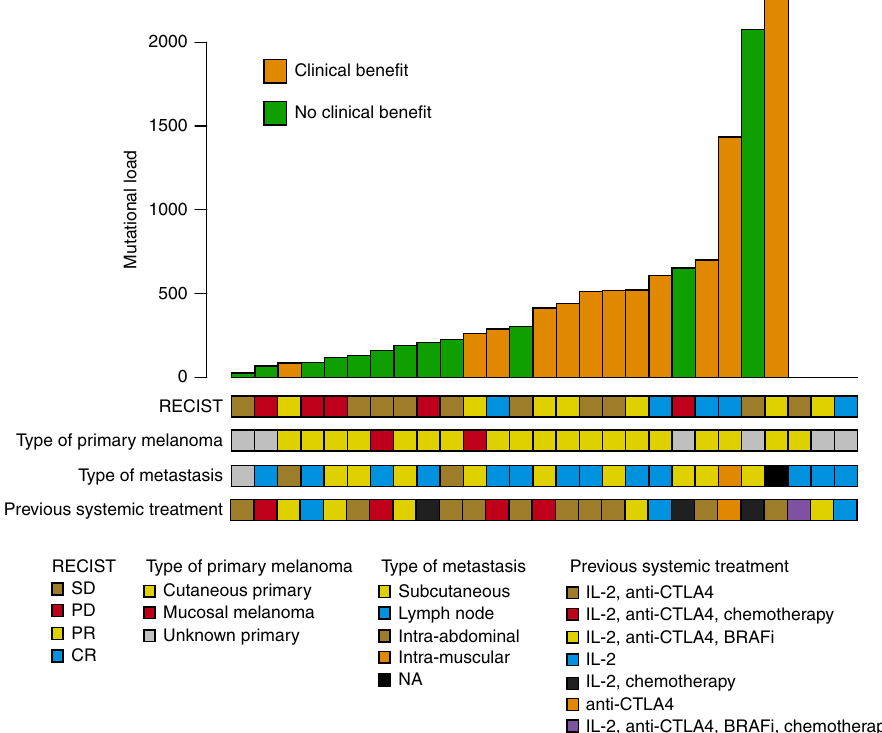
Fig. 1 Mutational load and clinical features of the cohort. Tumors are ordered according to mutational load and compared to clinical features. RECIST categories: CR complete response; PD progressive disease; PR partial response; SD\ stable